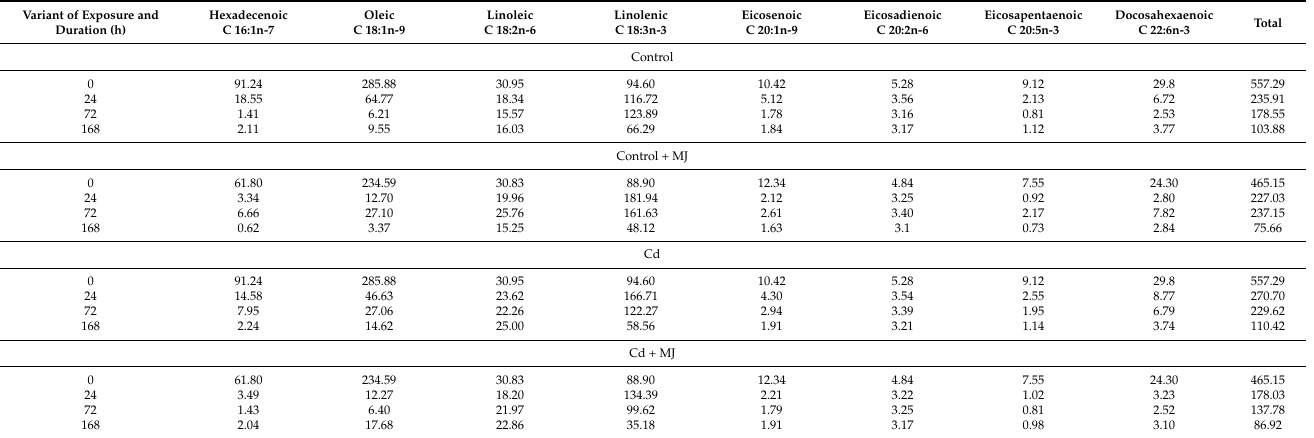
Table 6. Effect of exogenous MJ on the content of unsaturated FAs (mkl/mL) in wheat leaves under Cd